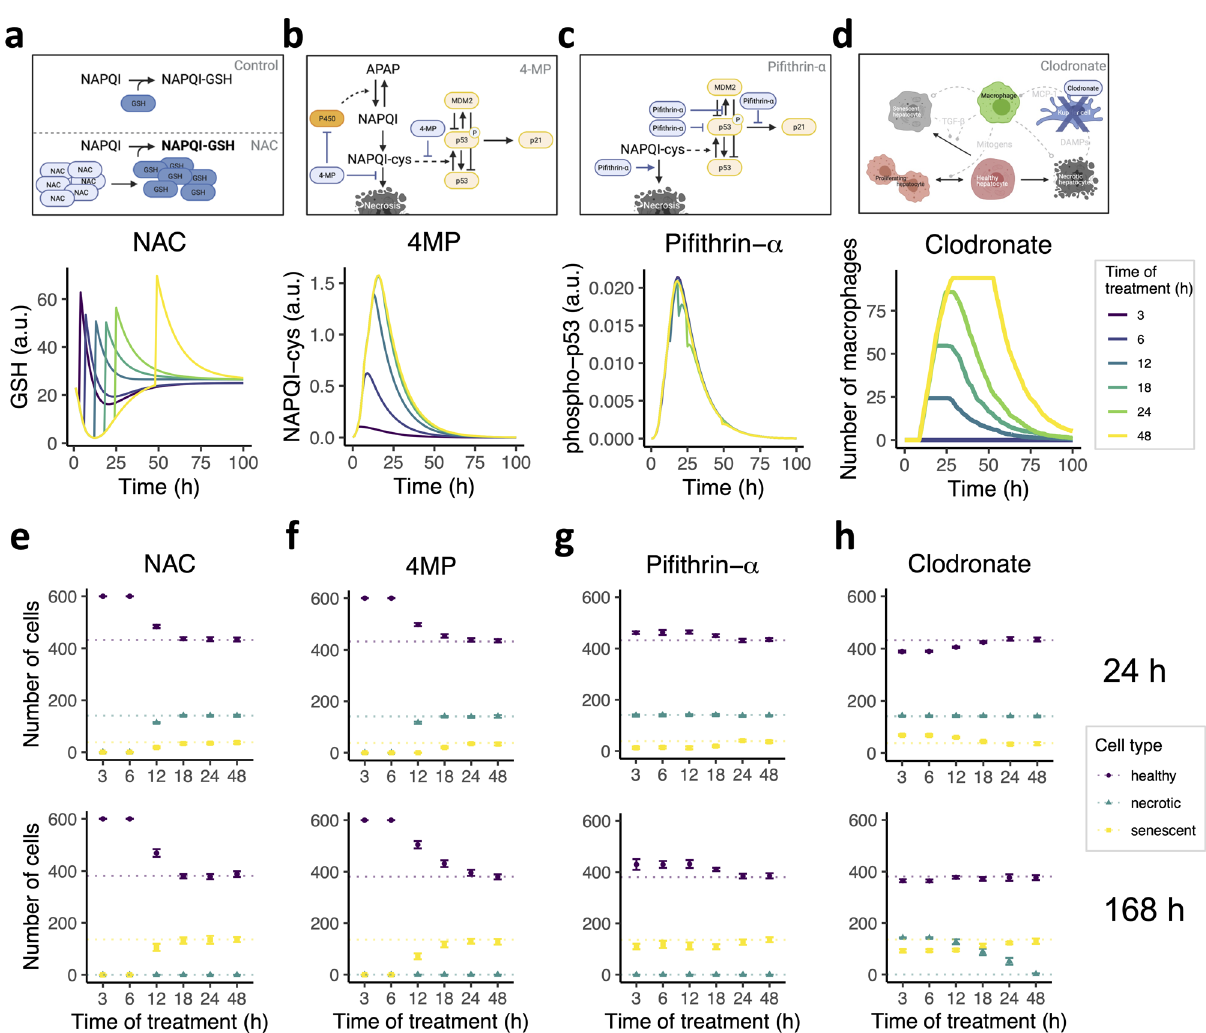
Fig. 6 In silico predictions for the effect of four therapies administered at 3, 6, 12, 18, 24, or 48 h on APAP-induced liver injury and recovery. a – d Graphical representation (top panels) and simulations (bottom panels) of the intracellular effect of ( a ) NAC on GSH concentration, ( b ) 4MP on NAPQI-cys abundance, ( c ) pi fi thrin- α on phospho-p53 concentration and ( d ) of the effect of KC depletion by clodronate on the number of macrophages. Top panels created with BioRender. e – h Effect of ( e ) NAC, ( f ) 4MP, ( g ) pi fi thrin- α and ( h ) clodronate therapies on the healthy, necrotic and senescent cell populations measured at 24 h (top panels) or 168 h (bottom panels). Dotted colored lines indicate simulation results without treatment. Results are based on ten simulations per condition represented as mean ± sd. a.u., arbitrary